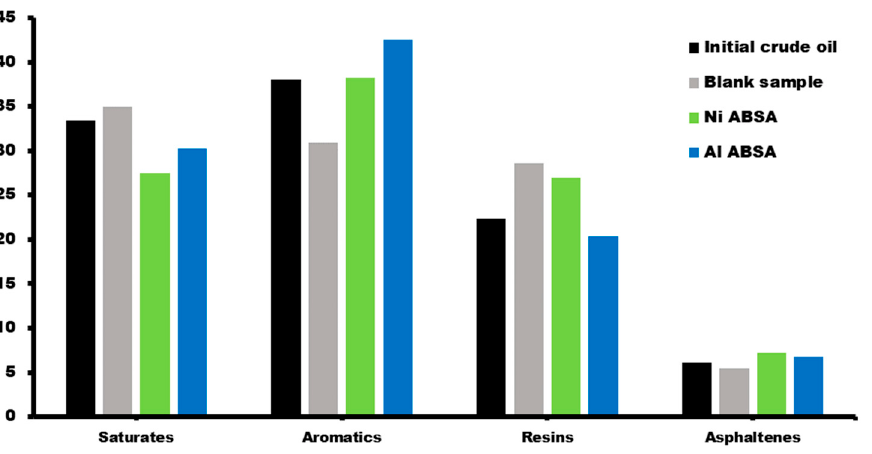
Figure 7. The SARA fractions of heavy-oil samples.